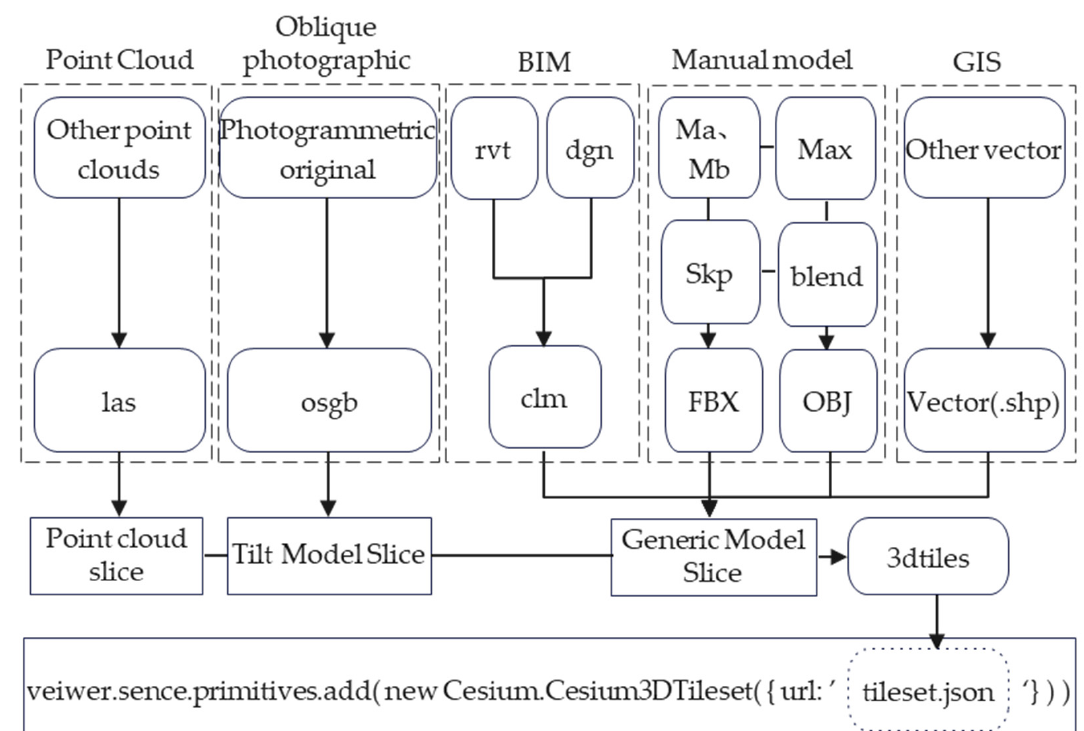
Figure 2. Cesium loads various 3D